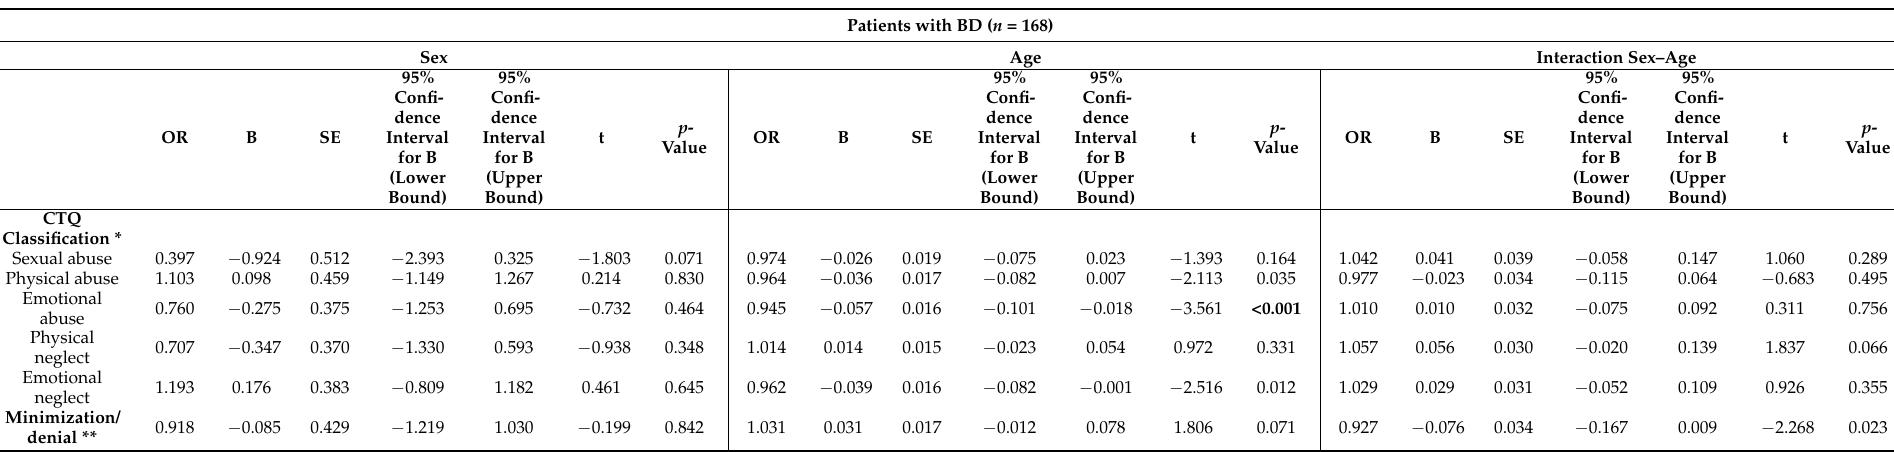
Table 5. Logistic regression analysis in patients with BD.